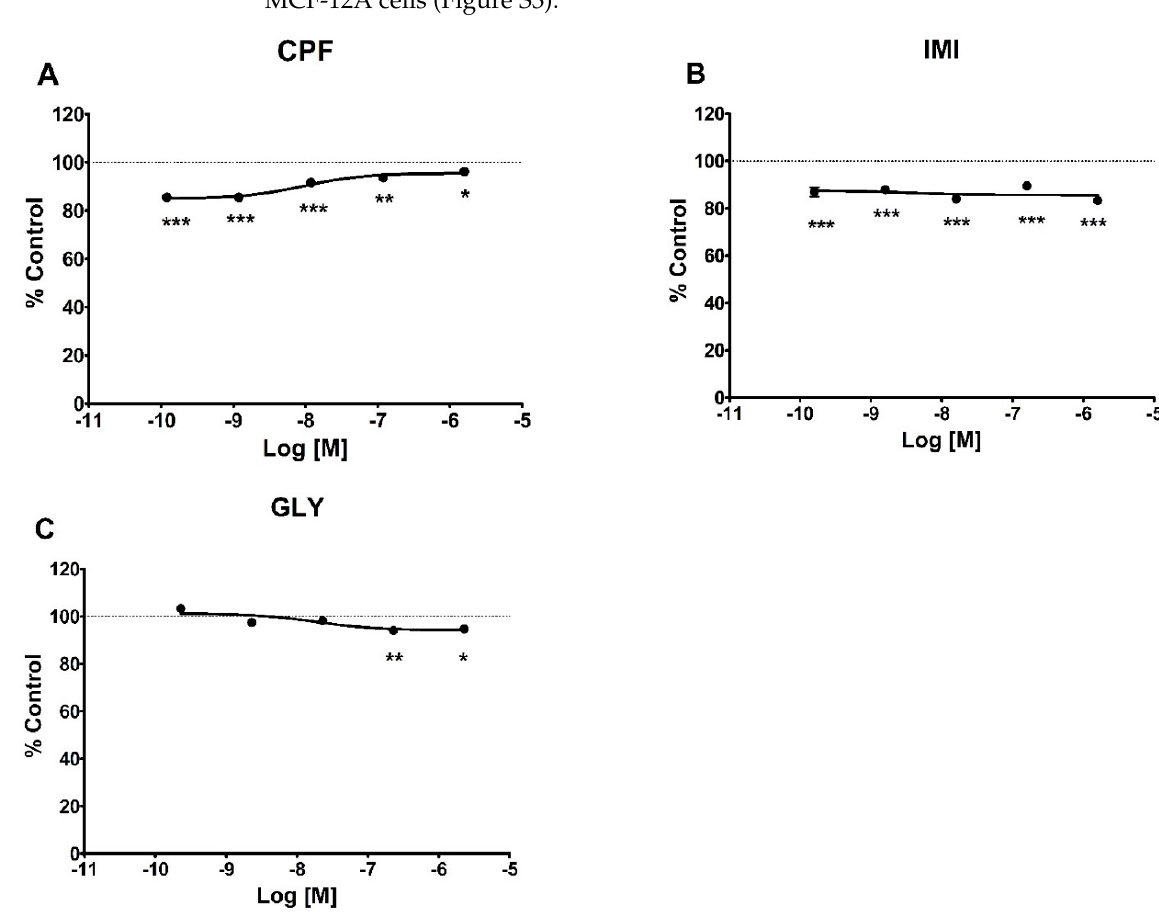
Figure 4. ATP levels in MCF-7 cells treated for 72 h with CPF, ( A ) IMI ( B ) or GLY ( C ). Values are means ± SEM of three independent experiments with control cells set at 100%. Asterisks indicate statistically significant differences with respect to control cells: * p < 0.05; ** p < 0.01; *** p < 0.001.